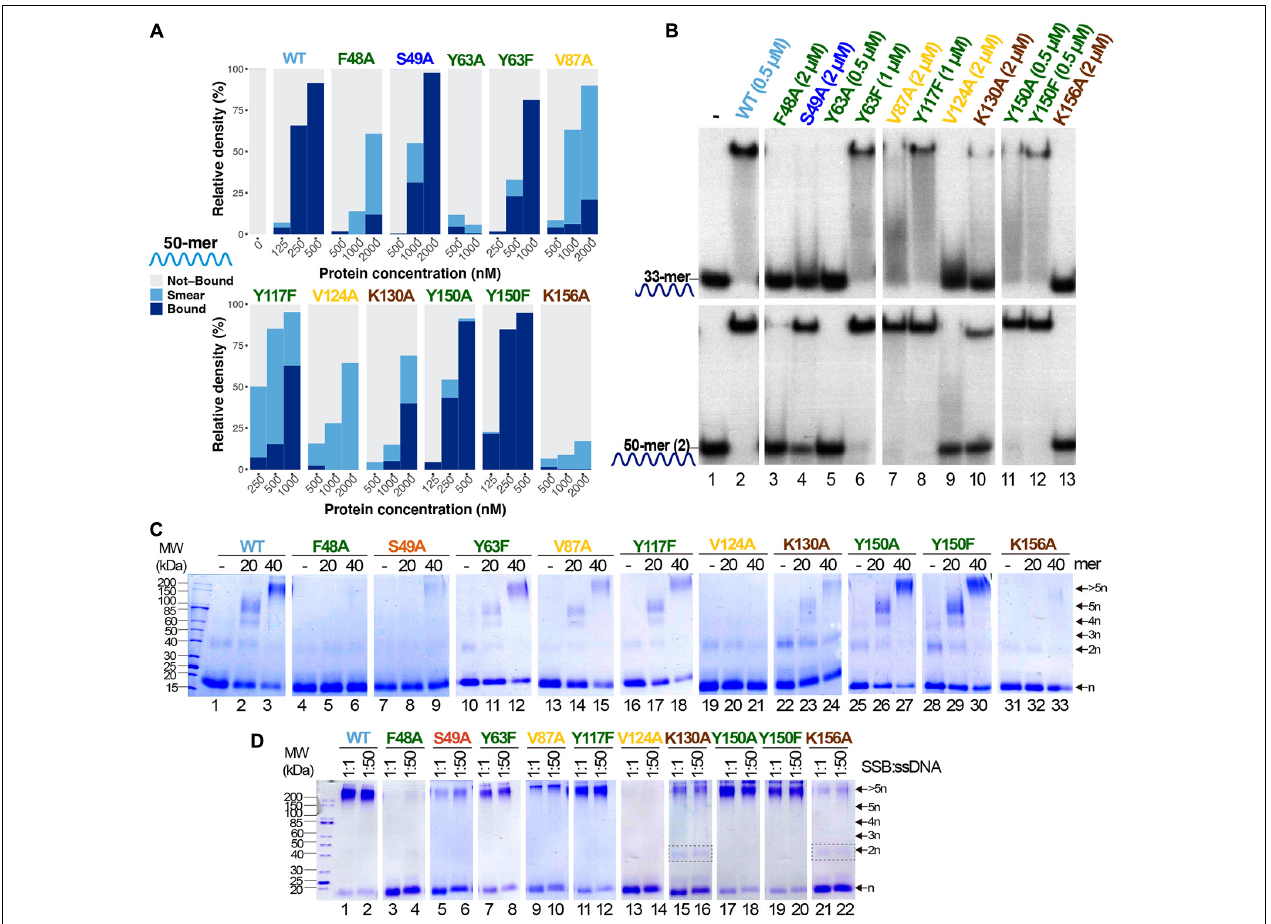
FIGURE 5 | Study of ssDNA-binding ability of B35SSB variants. (A) Representative graphic of EMSA assay with B35SSB variants quantified with ImageJ. EMSA was performed using the 50-mer ssDNA probe ( Supplementary Table 1 ) and the indicated concentration of B35SSB. Note that the B35SSB concentration range was adapted for each variant. (B) Effect of ssDNA size in the ssDNA-binding capacity of B35SSB variants. EMSA was performed incubating the indicated concentration of B35SSB or its variants with 33-mer or 50-mer(2) substrates as previously described. (C) B35SSB variants cross-linking analysis using different ssDNA sizes. (D) Effect of SSB:ssDNA ratio in binding. One µ M B35SSB (or variants) was incubated either with 1 or 50 µ M 50-mer(2) ssDNA, according to the ratio protein:DNA indicated. Dimeric species for K130A and K156A are indicated with a gray rectangle. See section “Materials and Methods” for